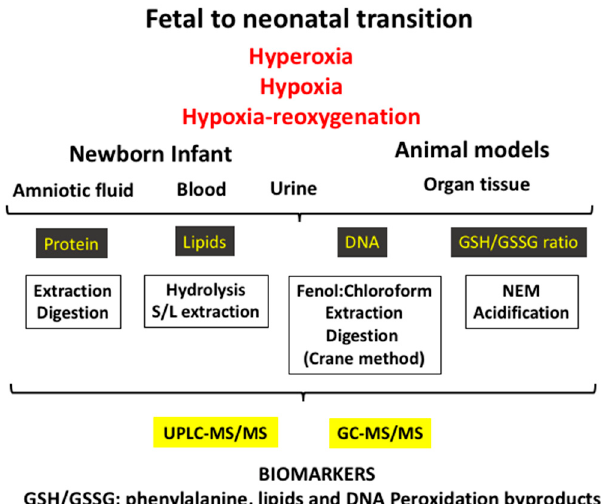
Figure 2. The fetal-to-neonatal transition increases exponentially the availability of oxygen to tissues, causing a physiological oxidative stress. However, under pathologic conditions (e.g., hyperoxia, hypoxia–reoxygenation, and hypoxia) a severe oxidative stress ensues that leads to pathologic